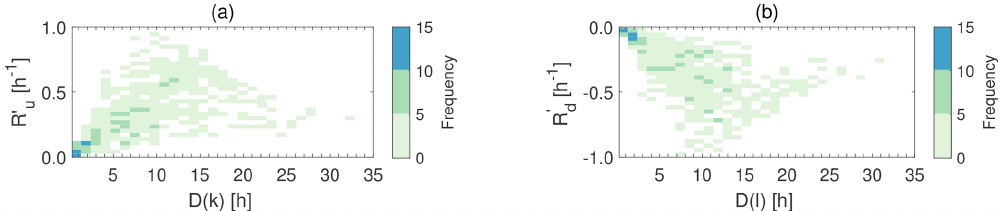
Figure 7. Distributions of normalised ramp rates as a function of duration for (a) ramp-up rates, R (cid:48) u ( k ), and (b) ramp-down rates, R (cid:48)